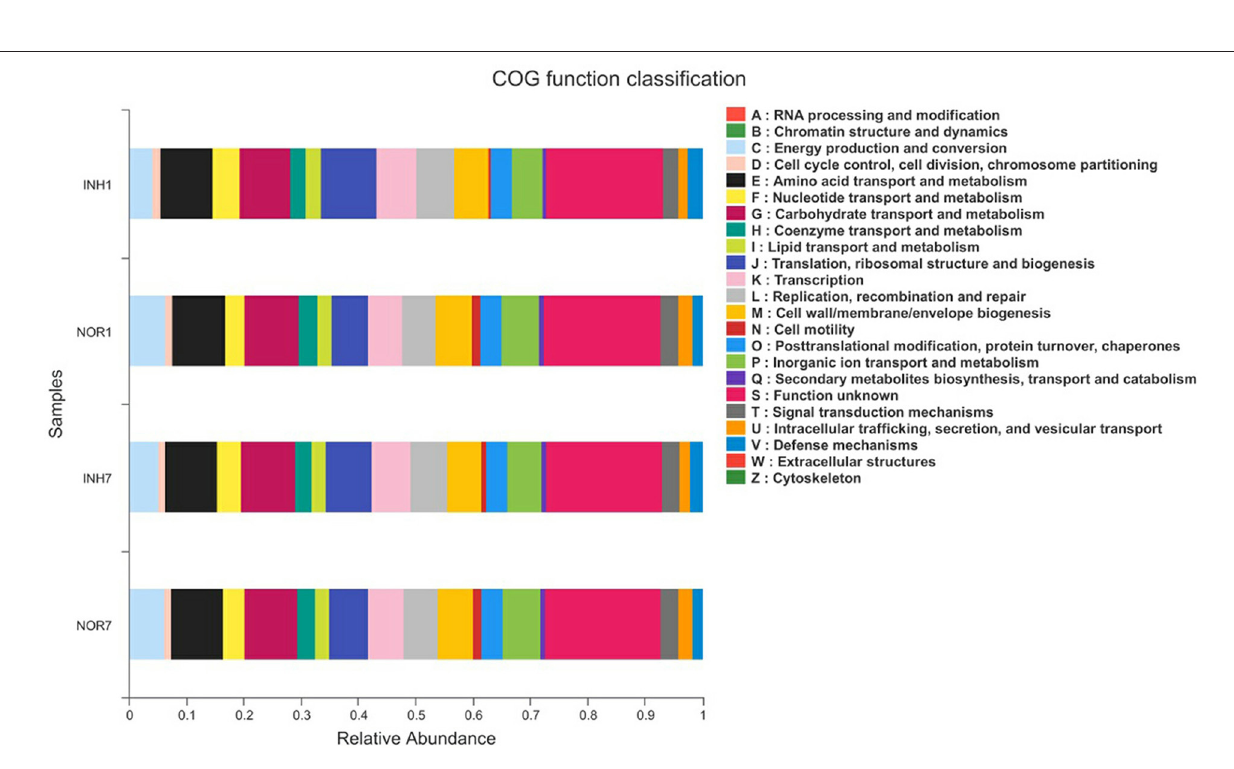
Frontiers in Pediatrics | www.frontiersin.org